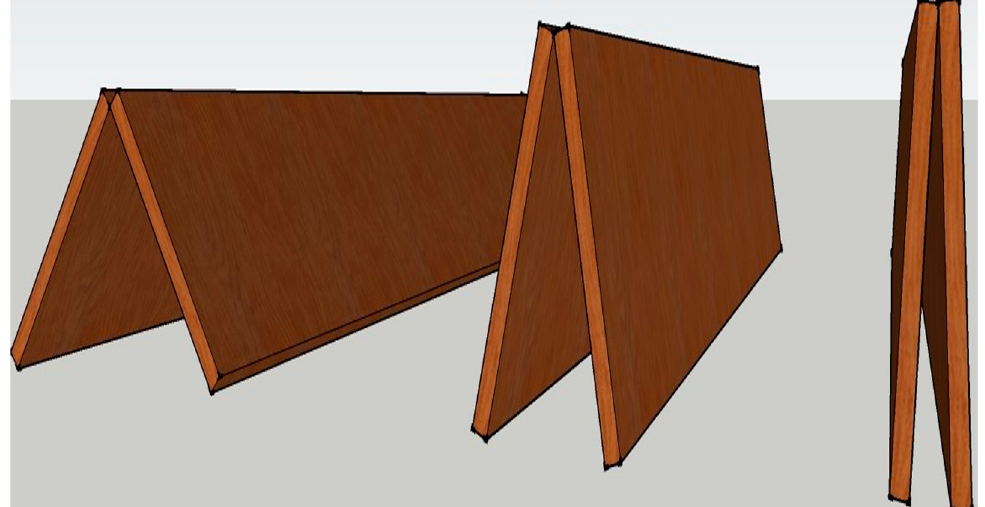
Figure 3. Roof panel folding.